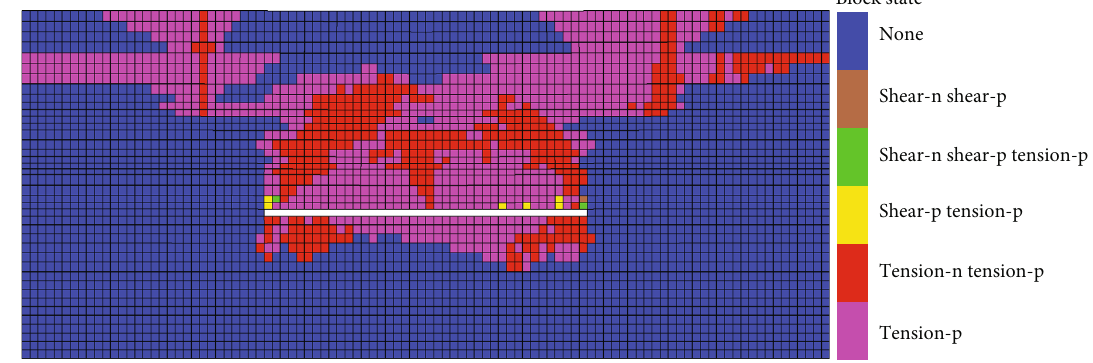
Figure 12: Distribution of plastic zone at excavation 240m.